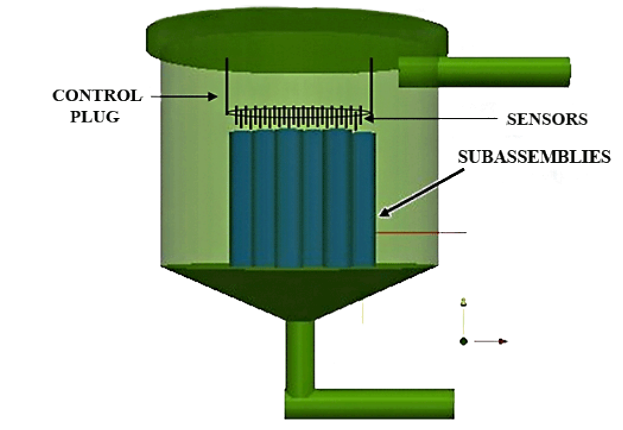
Figure 1. Basic structure of a fast reactor.